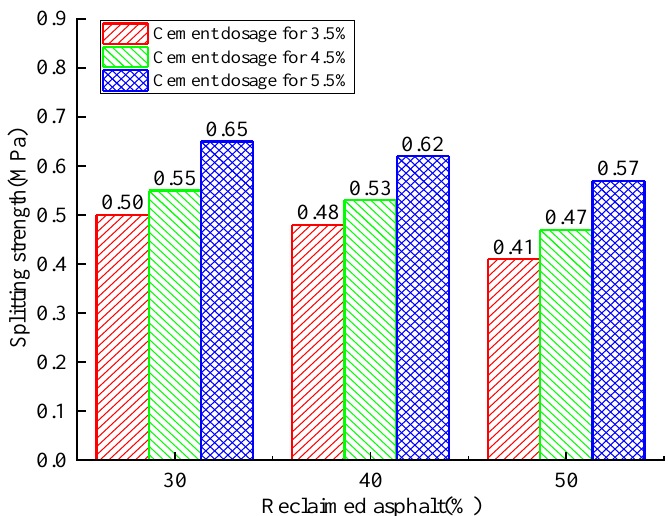
Figure 12. Analysis of the 28-day reclaimed asphalt splitting tensile-strength test with variation of cement dosage and RAP.